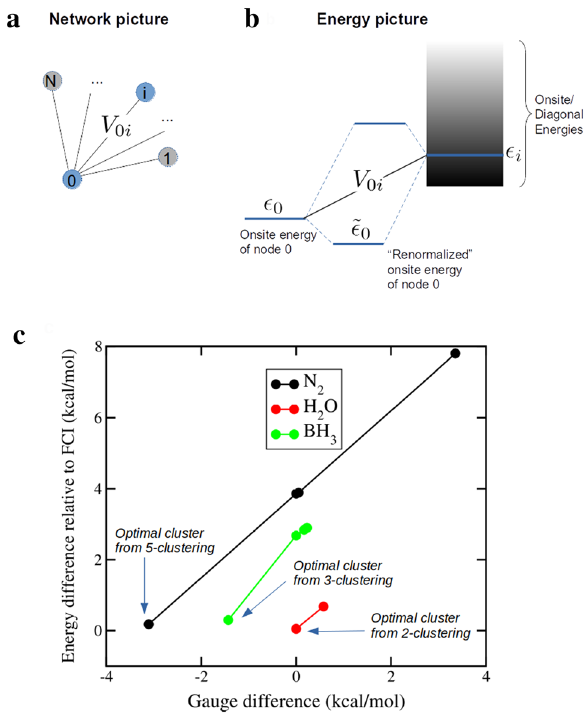
Figure 6. Gauge metric description. ( a ) Network representation of a cluster. ( b ) Scheme of how the energy of node 0 (diagonal element ǫ 0 ) gets re-normalized (corrected) to ˜ ǫ due to the interaction with the other nodes (SDs) via the coupling elements or weights V 0 i . ( c ) Gauge and energy differences are shown for H 2 O, BH 3 , and N 2 . The lowest gauge metric differences and corresponding energy differences denote the most accurate cluster. Pair-wise differences in the gauge metrics and the corresponding energy differences have a linear relationship as shown. The most accurate cluster across all k-clusterings is